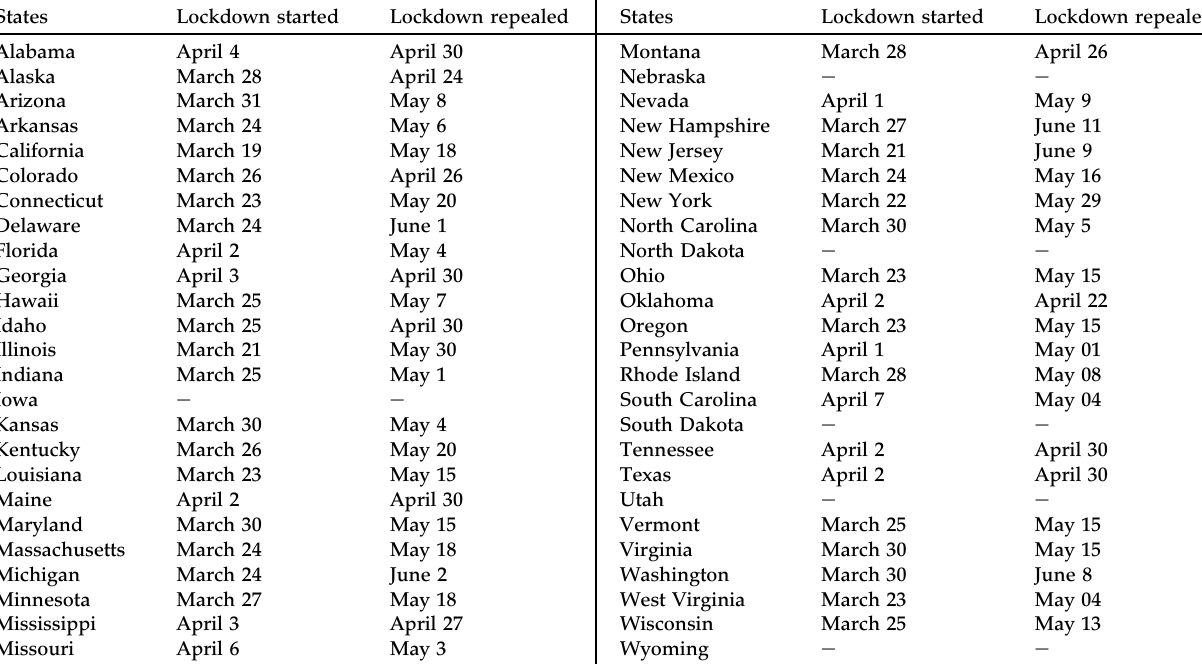
Table 2. Statewide lockdown period.